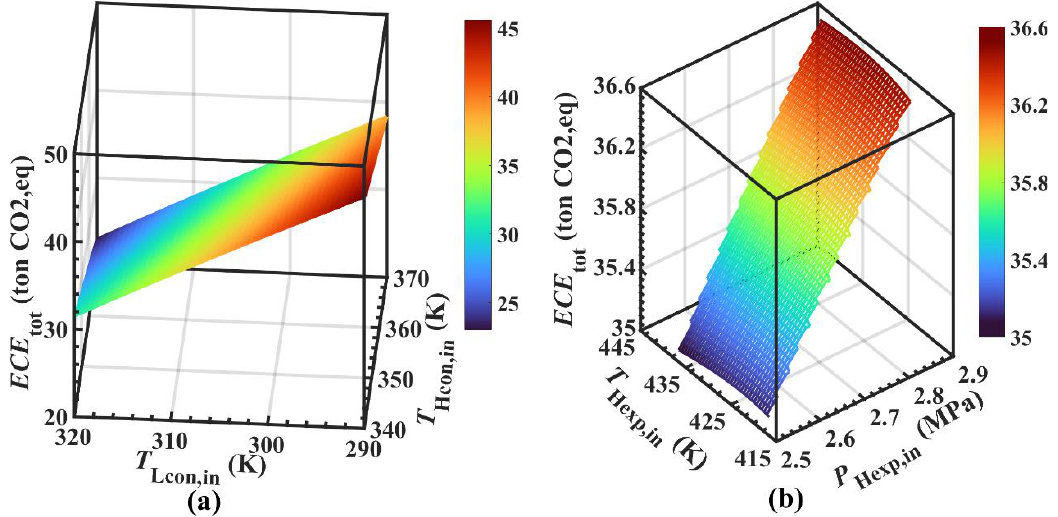
Figure 19. Influence characteristics of key variables on ECE. (a) Impact characteristics of condenser inlet temperature on system ECE. (b) Impact of expander inlet temperature and pressure on the HT cycle on system ECE.